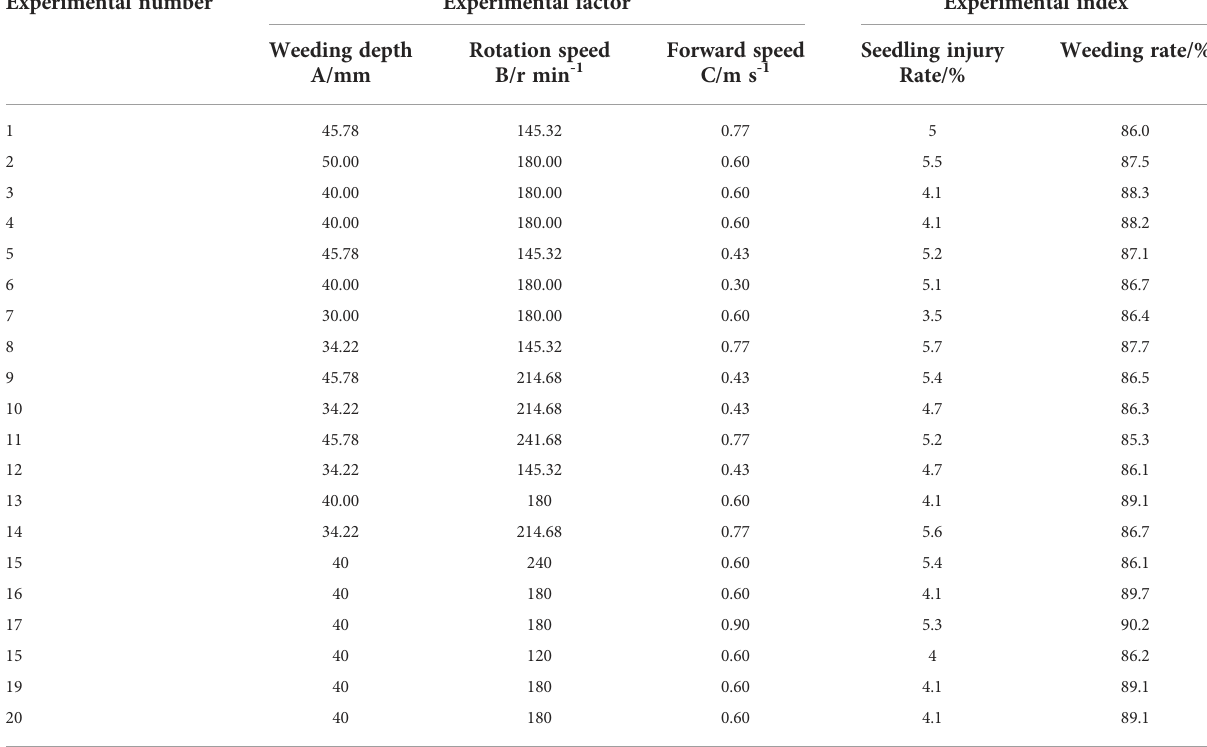
TABLE 3 Protocols and